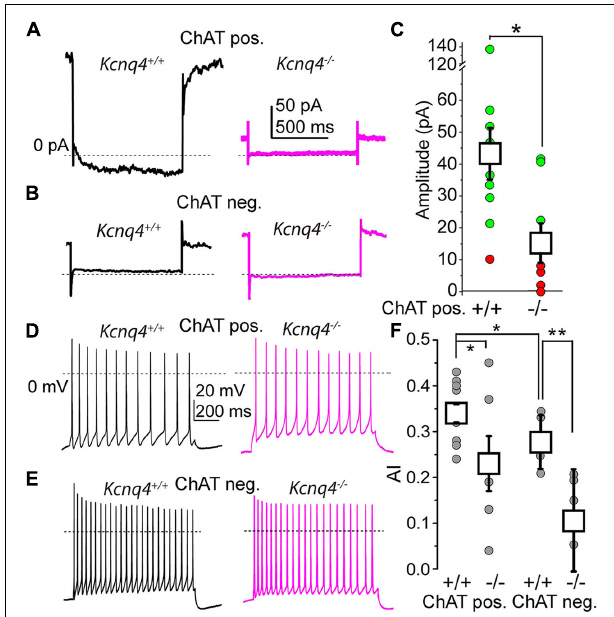
FIGURE 4 | More than 60% of the cholinergic neurons lack the M-current in KCNQ4 knockout (KO) samples. (A) Representative current traces from cholinergic neurons of a wild-type (WT; Kcnq4 + / + , black ) and a knockout (KO; Kcnq4 − / − , purple ) sample elicited by a 1-s-long repolarizing step from –20 mV holding potential to –40 mV. The mean values were 175.97 ± 27.67 pA for the WT and 66.95 ± 19.8 pA for the KO animals ( p = 0.0060). (B) Representative current traces from non-cholinergic neurons of the WT ( Kcnq4 + / + , black ) and KO ( Kcnq4 − / − , purple ) samples elicited by the same voltage protocol as in panel (A) . (C) Statistical comparison of the relaxation current of cholinergic neurons at –40 mV from the WT (+/+; n = 13) and KO (–/–; n = 8) samples ( green : the M-current exists; red : no M-current detected; white squares : mean ± SD). The average relaxation current at –40 mV was 42.57 ± 7.95 pA in the WT and 14.85 ± 6.12 pA in the KO animals ( p = 0.0133). Dotted lines indicate 0 pA. All non-cholinergic neurons lacked the M-current. (D,E) Representative voltage traces obtained from the WT ( Kcnq4 + / + , black ) and KO ( Kcnq4 − / − , purple ) samples from cholinergic (D) and non-cholinergic (E) neurons elicited by a 1-s-long square current pulse with 100 pA amplitude. Dotted lines indicate 0 mV. (F) Statistical comparison of the adaptation index (AI) of the cholinergic ( ChAT pos. ) and non-cholinergic ( ChAT neg. ) neurons from the WT (+/+) and KO (–/–) samples ( gray circles : individual data; white squares : mean ± SD). * p < 0.050; ** p < 0.010 ( n = 9 for WT cholinergic, n = 6 for KO cholinergic, and n = 5 for WT and KO non-cholinergic neurons). For cholinergic cells, the AIs were 0.34 ± 0.02 in the WT and 0.23 ± 0.04 in KO mice ( p = 0.0399; n = 6 for KO and n = 9 for WT). For non-cholinergic cells, the AIs were 0.28 ± 0.06 in the WT and 0.11 ± 0.11 in KO mice ( p = 0.0094; n = 5 for